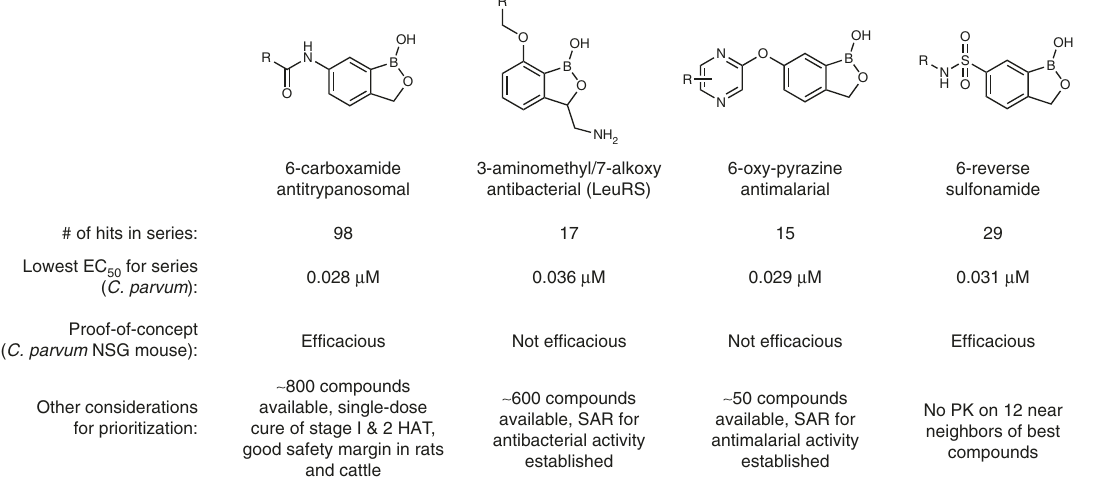
Fig. 1 Screening results and prioritization considerations. Con fi rmed anticryptosporidial screening hits, lowest EC 50 , and prioritization considerations for four benzoxaborole chemical scaffolds are shown. The 6-carboxamide antitrypanosomal chemical scaffold was prioritized for further study based on a large number of available analogs, existing safety data from a human African trypanosomiasis (HAT) drug development program, and the results of a preliminary murine ef fi cacy